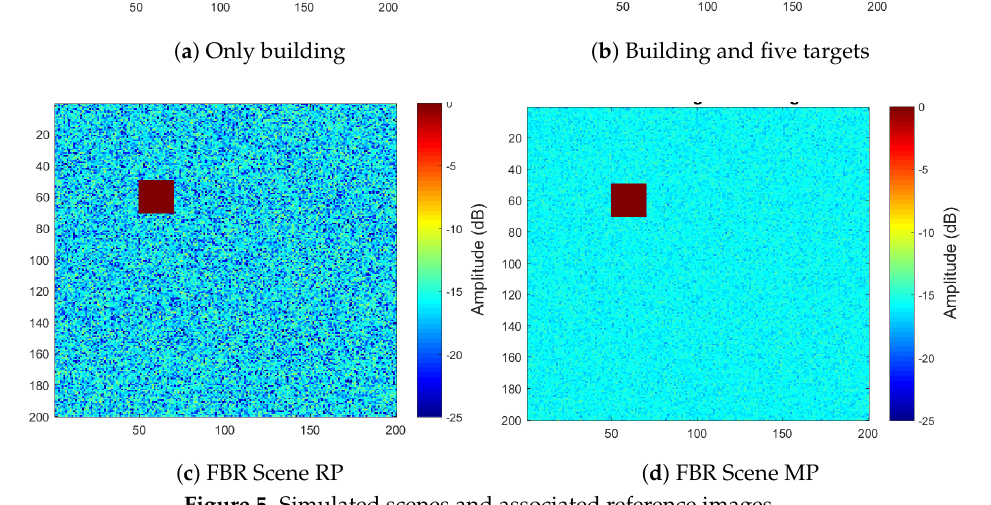
Figure 5. Simulated scenes and associated reference images.